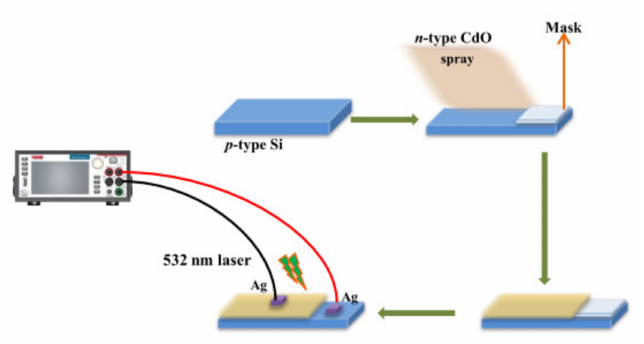
Figure 5. The schematic diagram of the prepared p -Si/ n -CdO:Ag